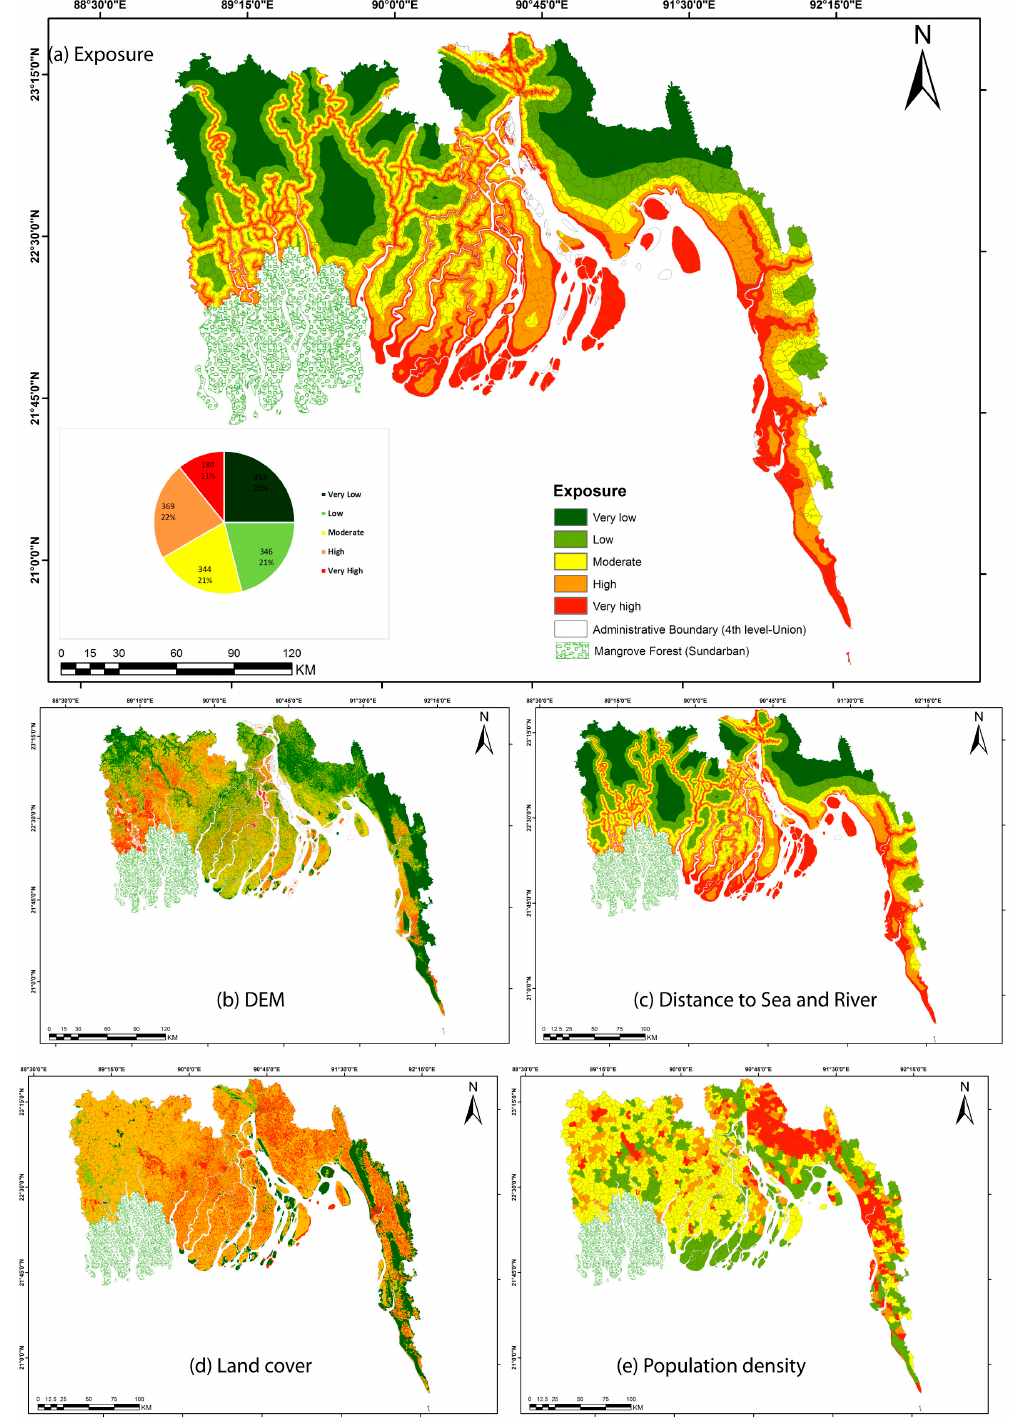
Figure 6. Exposure map of the study area. Exposure index has been calculated by equal weighted sum of four exposure indicators: DEM ( b ); distance to sea and river ( c ); land cover ( d ); and population density ( e ).